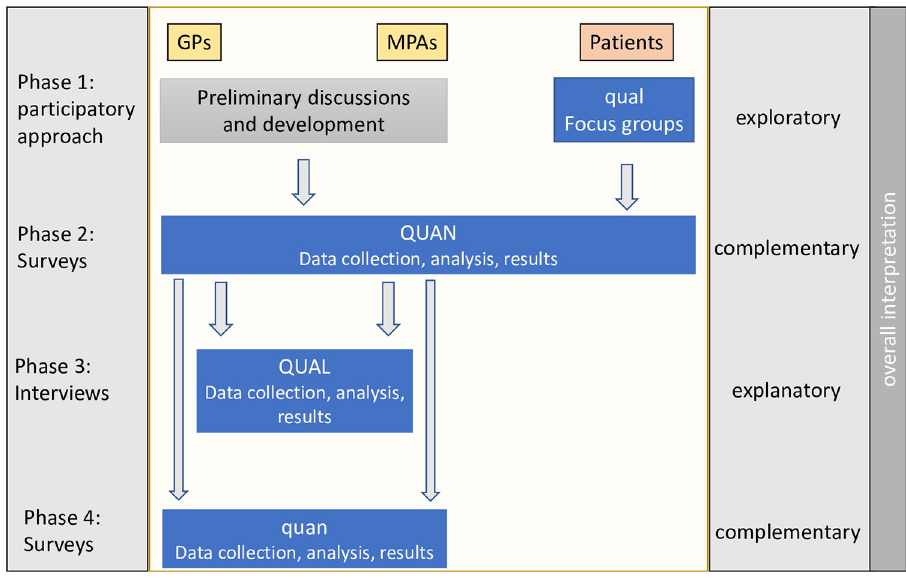
Fig 2. Mixed methods